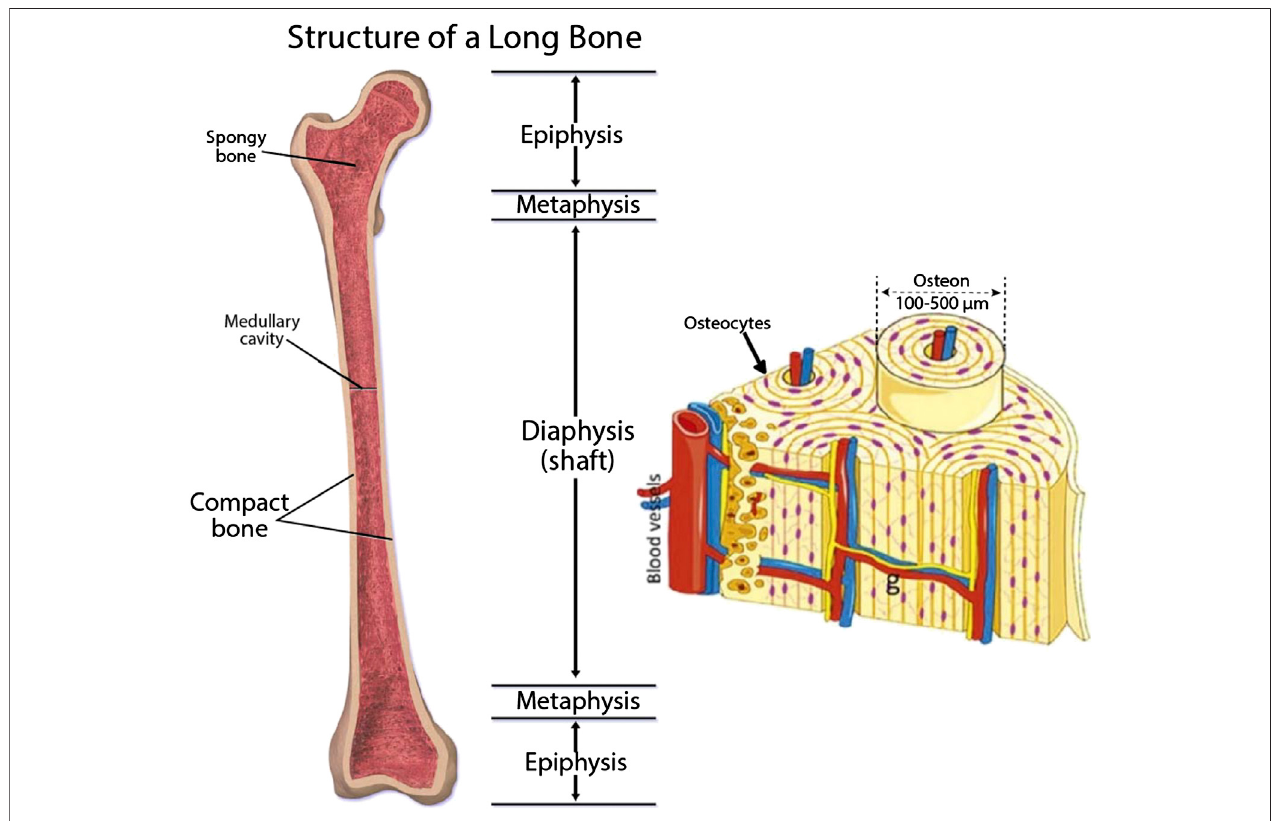
FIGURE 8 | Structure and components of bone (Blausen.com Staff 2014; Gong et al., 2015) (used from an open access journal).